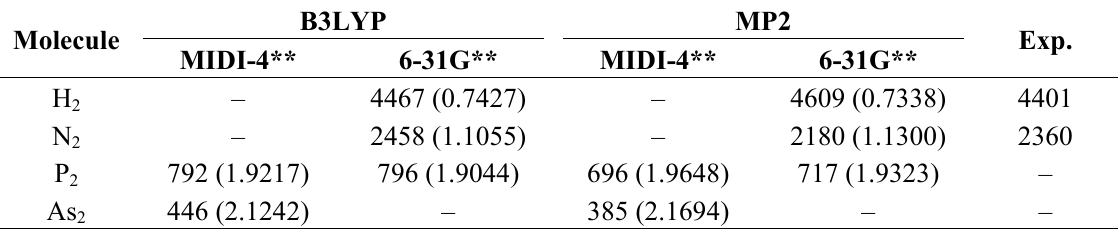
Table 2. Diatomic molecule (cm − 1 ) frequencies. The values in parentheses are the optimized bond lengths (Å). B3LYP and MP2 represent the calculations at the B3LYP/Y and MP2/Y (Y = MIDI-4** or 6-31G**) levels, respectively. The experimental values are those obtained by Huber et al.